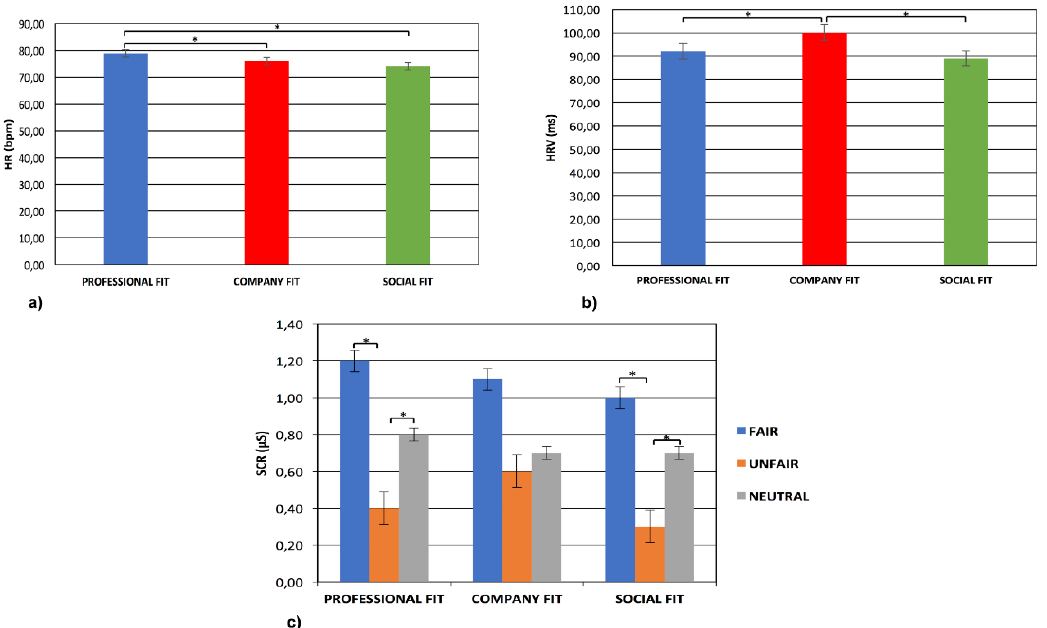
others. Bars represent ± 1SE. Stars mark statistically significant ( p < 0.05) pairwise comparisons. b) The figure shows a heart rate variability (HRV) increase in company fit condition compared to others. Bars represent ± 1SE. Stars mark statistically significant ( p < 0.05) pairwise comparisons. c) The figure shows a skin conductance response (SCR) increase for fair and neutral offers compared to unfair ones in professional and social fit conditions. Bars represent ± 1SE. Stars mark statistically significant ( p < 0.05) pairwise comparisons.